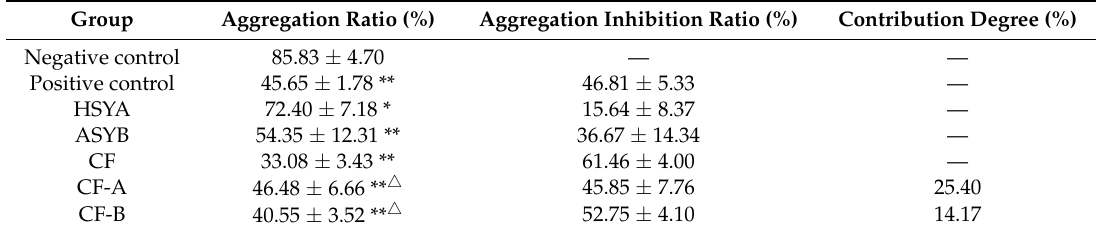
Table 1. Samples before and after knocking out the target component and knock-out constituents